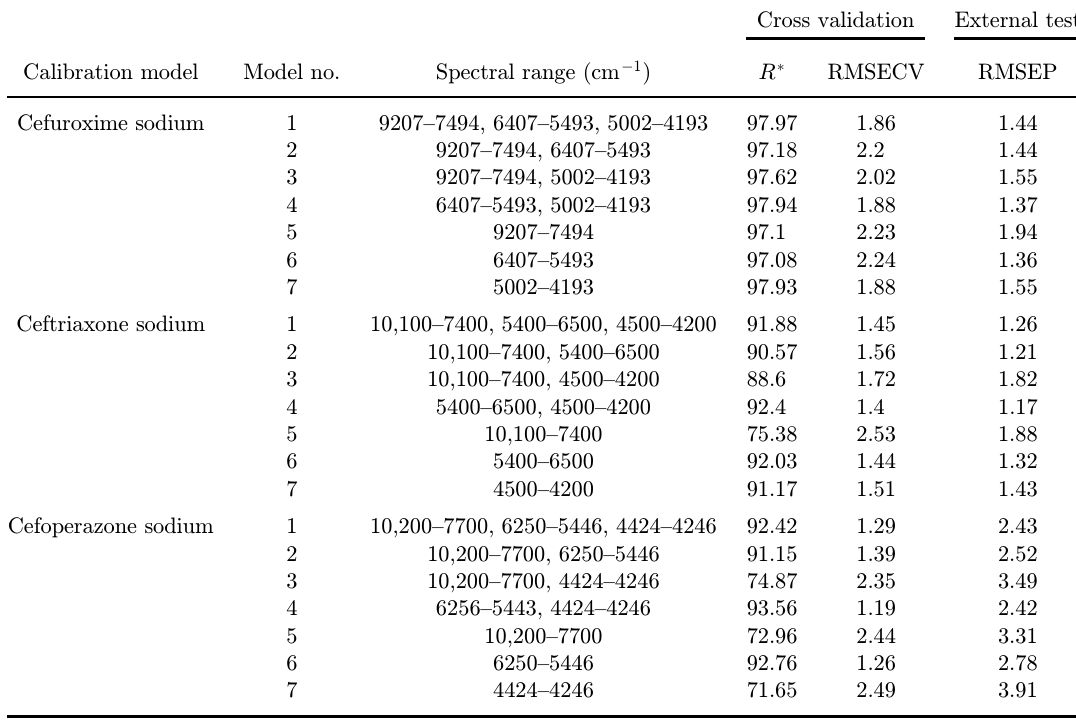
Table 3. Characteristics of models obtained with di®erent spectral ranges.